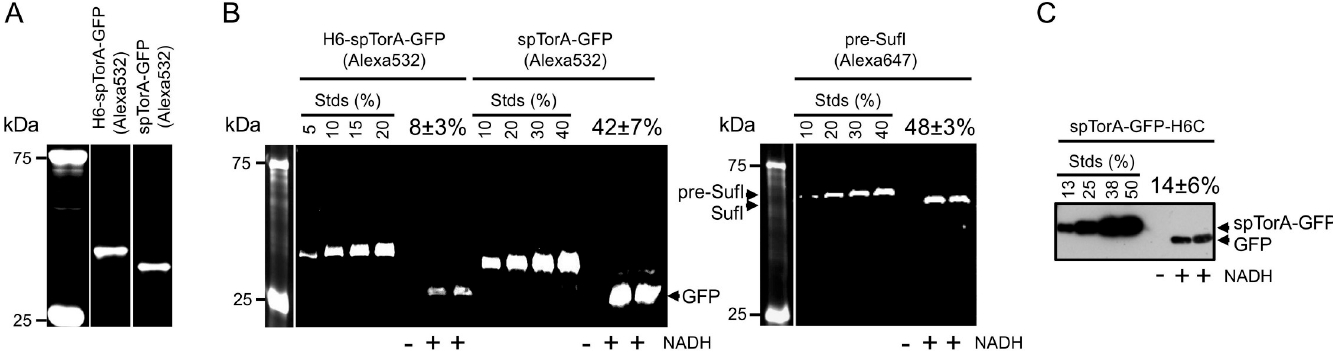
Fig 5. In vitro transport efficiencies of Tat substrates. (A) Purified spTorA-GFP(Alexa532) after TEV protease cleavage of H6-spTorA-GFP(Alexa532). (B & C) Transport assays analyzed by in-gel fluorescence (B) or Western blotting (C). Transport assays were conducted with 50 nM precursor proteins and Tat ++ IMVs ( A 280 = 5) for 10 min at 37˚C. Transport efficiencies are indicated as the amount of protease-protected (571 μ g/mL proteinase K treatment for 20 min) mature-length protein as the percent of total added precursor from at least 4 independent assays. These data suggest that the transport of spTorA-GFP is reduced by ~5- and 3-fold with a 6xHis- tag at the N- or C-terminus, respectively (but see Fig 6), and that the transport efficiency of spTorA-GFP is ~80% of that observed for pre-SufI. Transport was not observed in the absence of NADH (control).